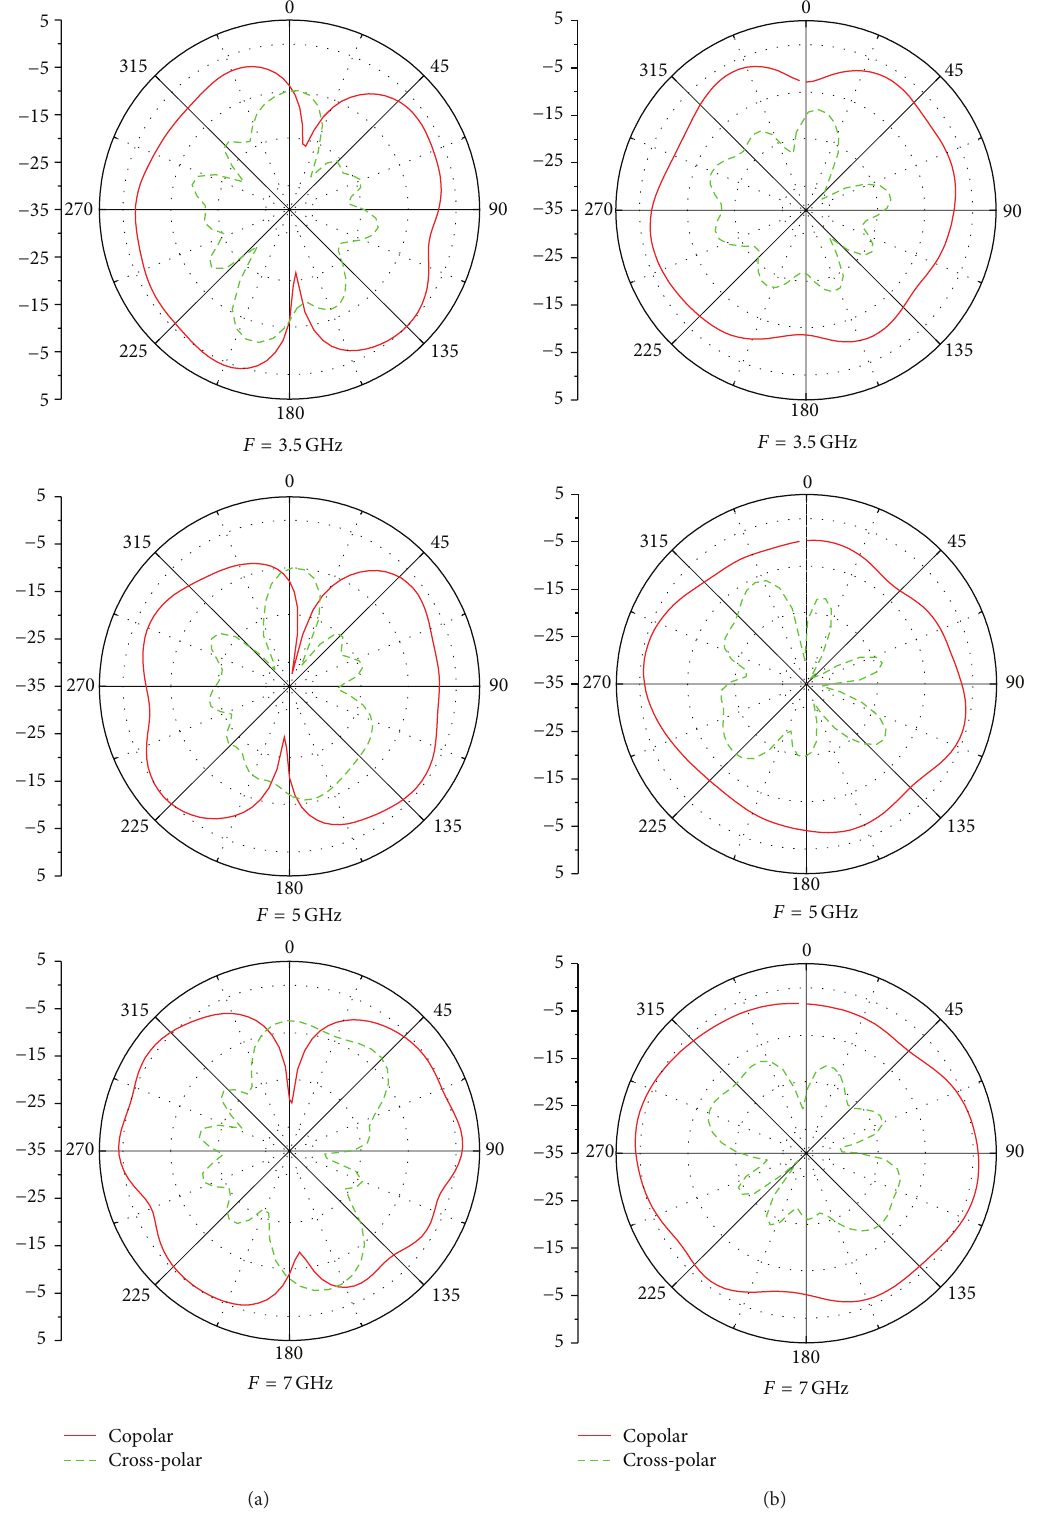
Figure 6: Measured radiation patterns at (a) 𝑦𝑧 -plane and (b) 𝑥𝑦